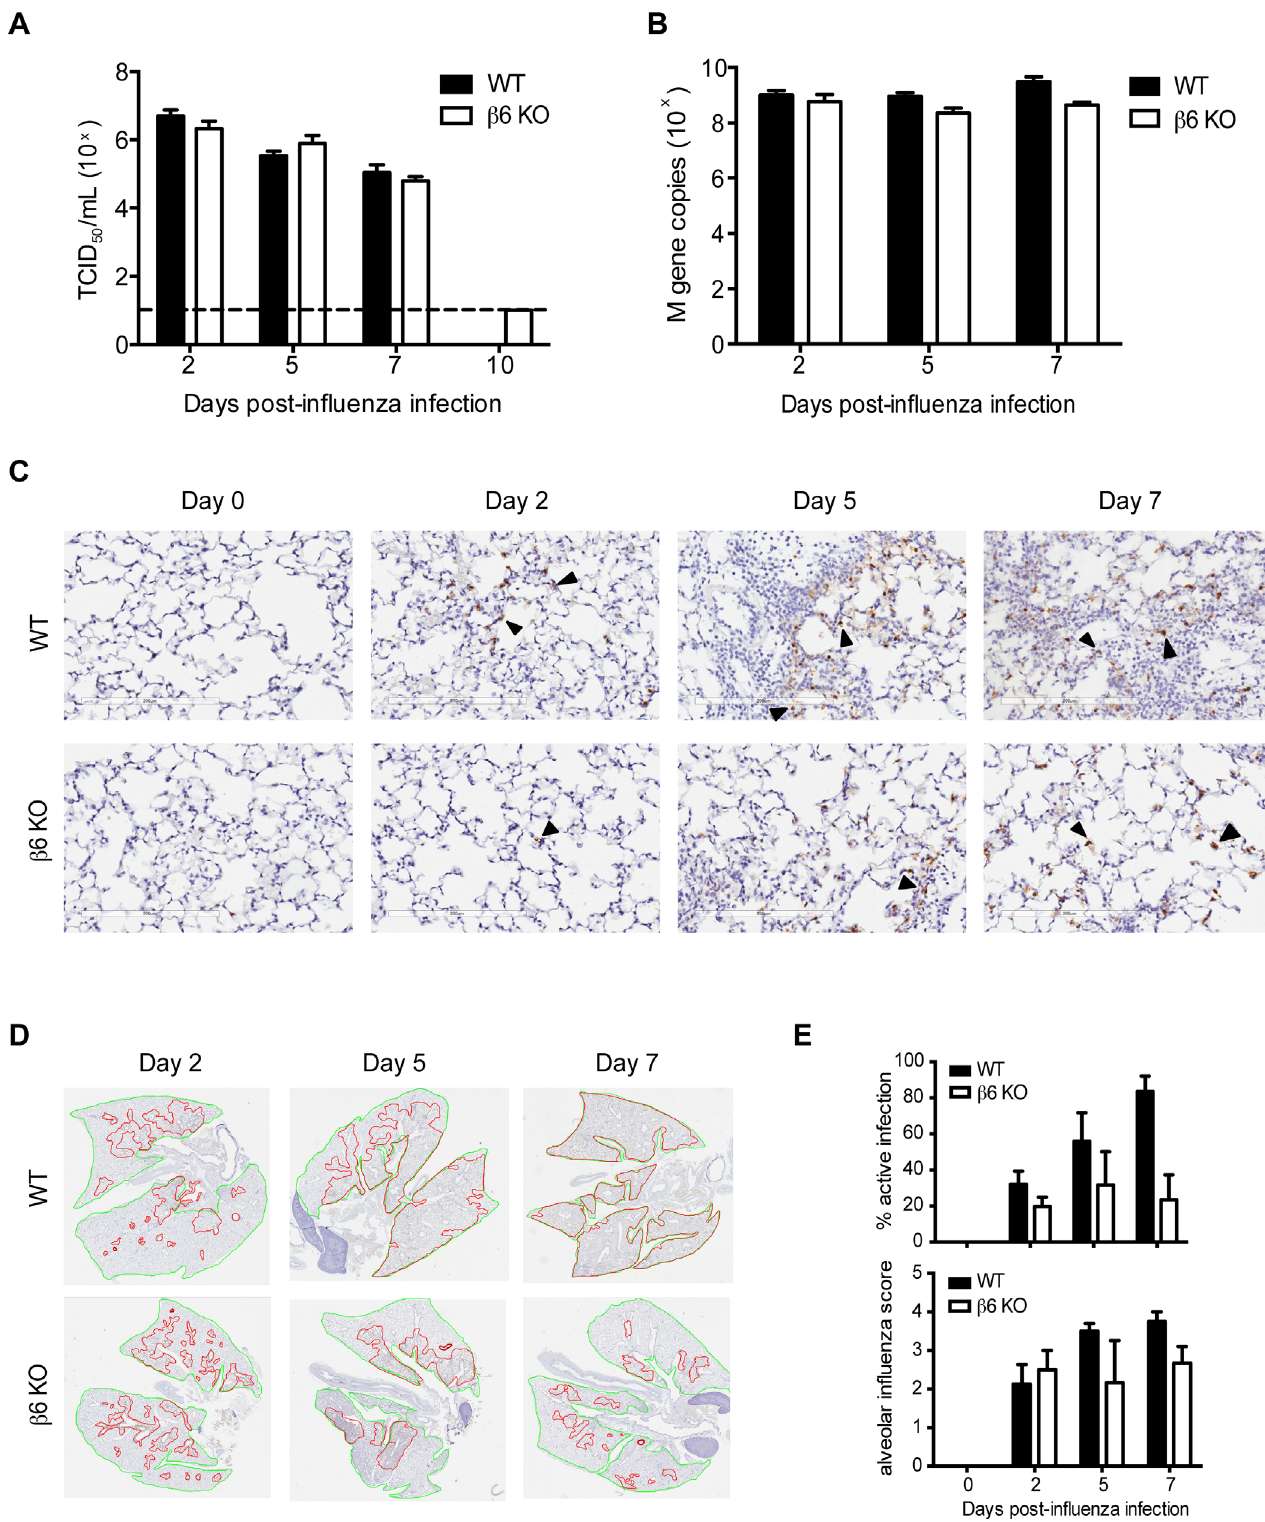
Fig 3. Improved survival in β 6 KO mice is independent of overall viral titers, although lung viral spread is affected. (A) Viral titers in whole lung homogenates from CA/09 influenza were determined by TCID 50 assay. Dotted line = limit of detection. Data are from 6